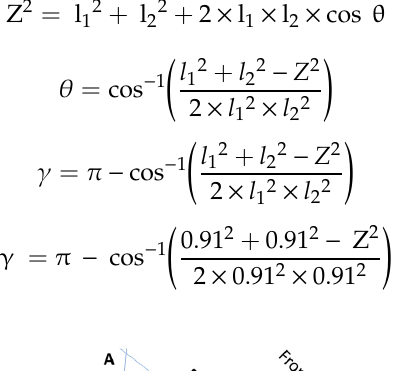
Figure 3. Context diagram of the Network Transport of RTCM via Internet Protocol (NTRIP).